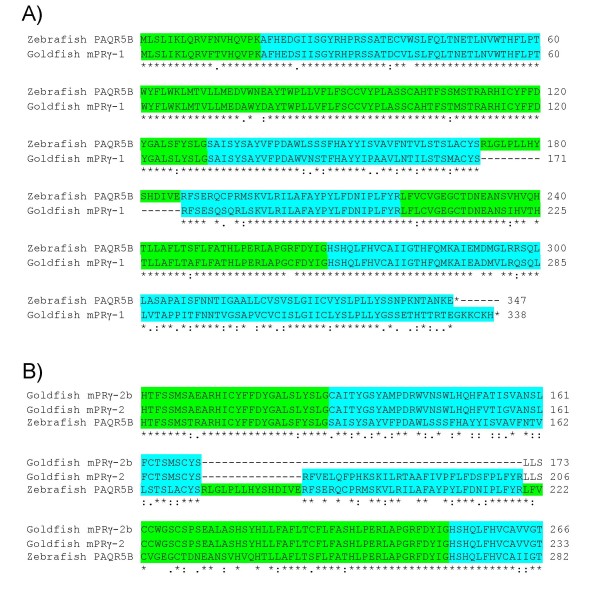
Alignment of membrane progestin receptor splice variants from the fish olfactory epithelium. Exon composition of PAQR5b and mPRγ-1 (A, alternating colours) and alignment of two mPRγ-2 splice variants from goldfish olfactory epithelium (B, colours represent corresponding exons 5 and 6 in PAQR5b).